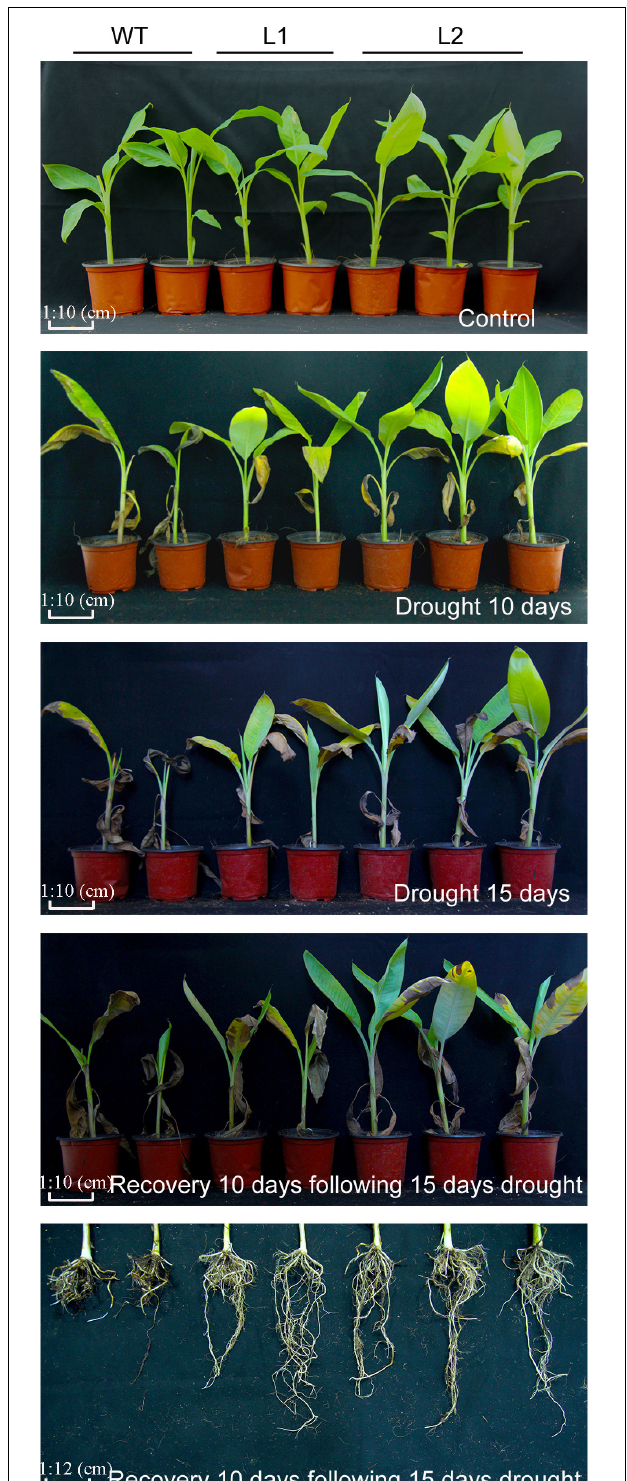
FIGURE 3 | Phenotype differences between WT and transgenic plants under normal, drought, and recovery conditions. Banana seedlings (100-day-old) were subjected to water withholding for 10 and 15 days, and recovery for 10 days following 15 days drought treatment, then the photos were